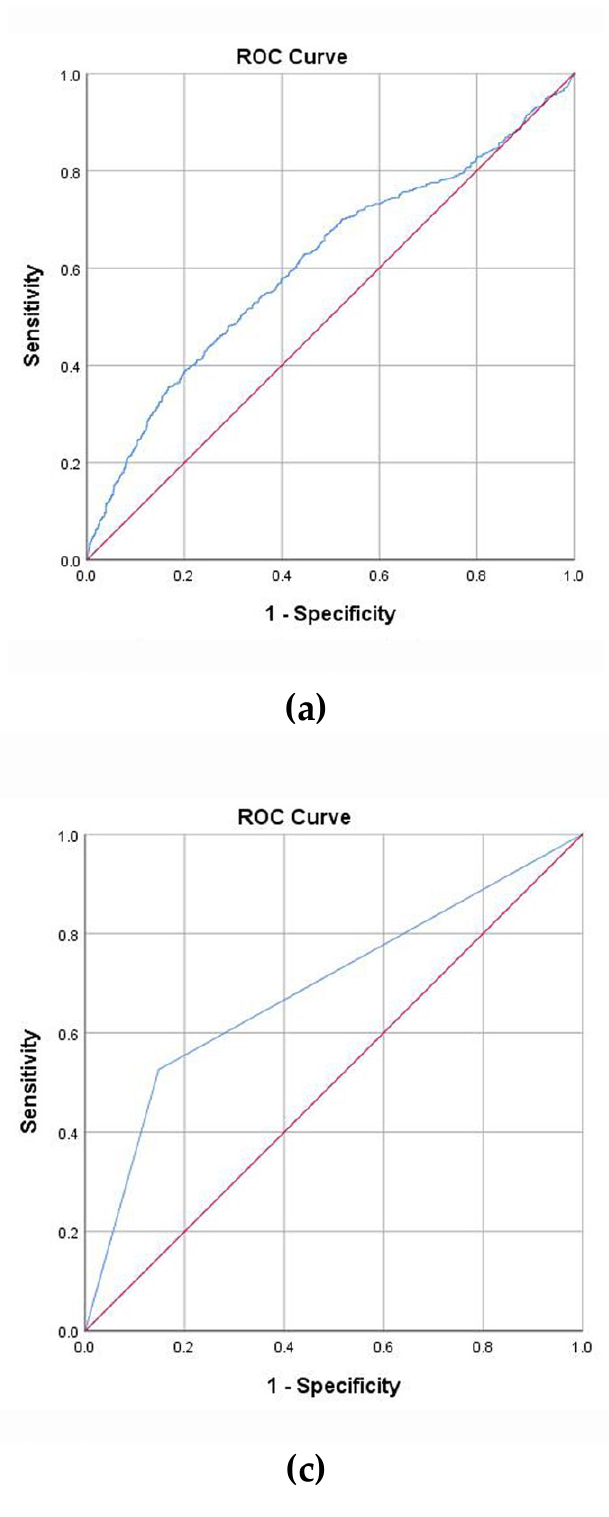
Figure 1. Risk factors and the combined method for predicting LNM in the model establishing group. ( a ) Tg. ( b ) Age. ( c ) US alone. ( d ) Combined diagnosis. LNM, lymph node metastasis; ROC, receiver operating characteristic; Tg, serum thyroglobulin; US,